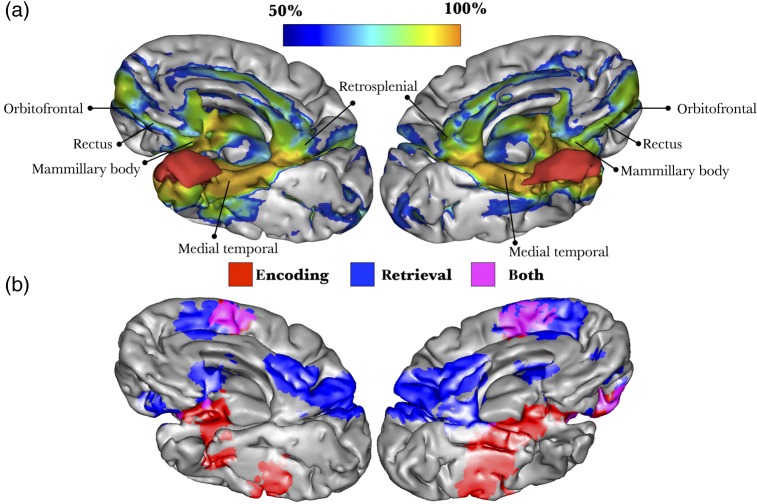
3D reconstruction of Molaison's brain registered in MNI space. (a) The damage produced by the surgery (red) affected cortical regions and subcortical white matter. A blue-to-orange gradient indicates the probability of disconnection of areas not directly affected by the excision. (b) Meta-analysis of functional MRI studies reporting activations related to encoding and retrieval of declarative memories (Spaniol et al. 2009).